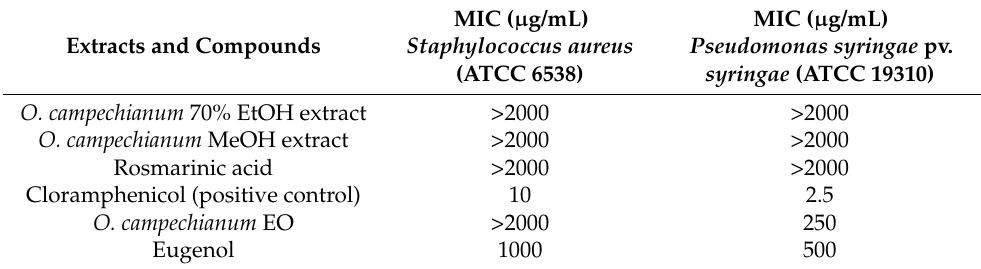
Table 4. MICs of O. campechianum extracts, EO, and main compounds.